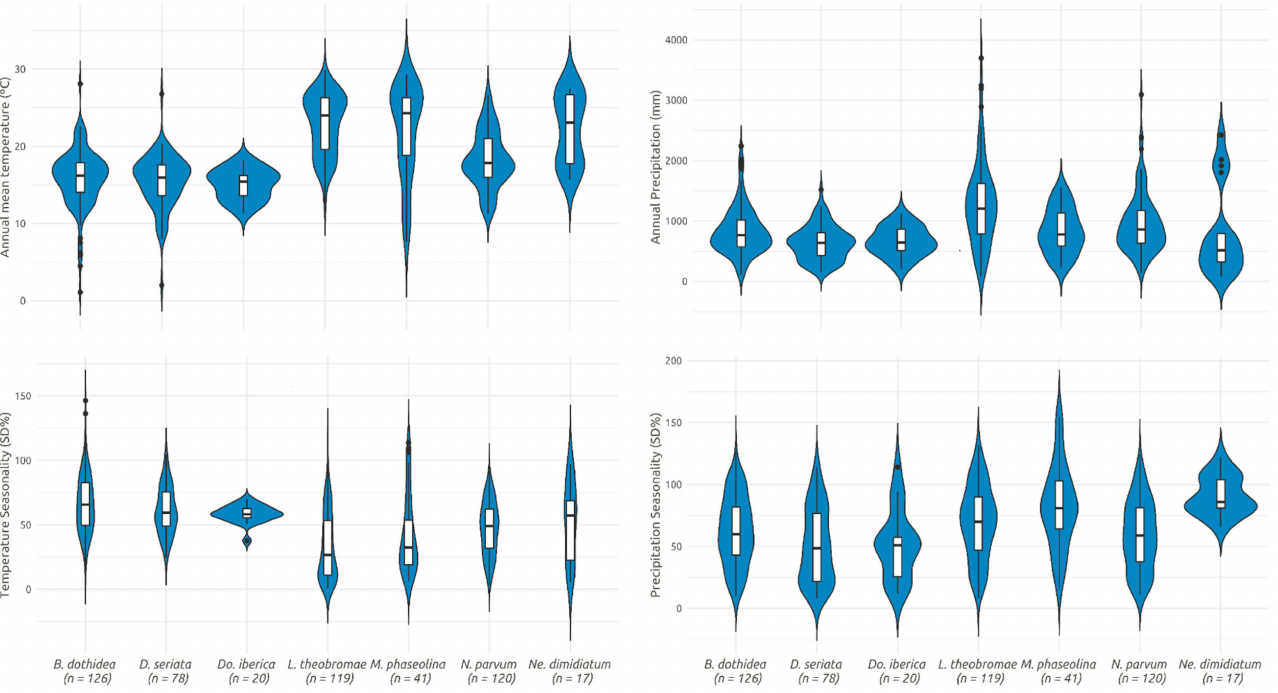
Figure 7. Annual mean temperature and precipitation and temperature and precipitation seasonality for the main Botryosphaeriaceae species occurrence. Data were thinned by 200 km distance to avoid spatial autocorrelation using the R package ELSA (Entropy-Based Local Indicator of Spatial Association) [84]. Climatic variables were extracted from the CHELSA project. Number of valid coordinates are indicated per